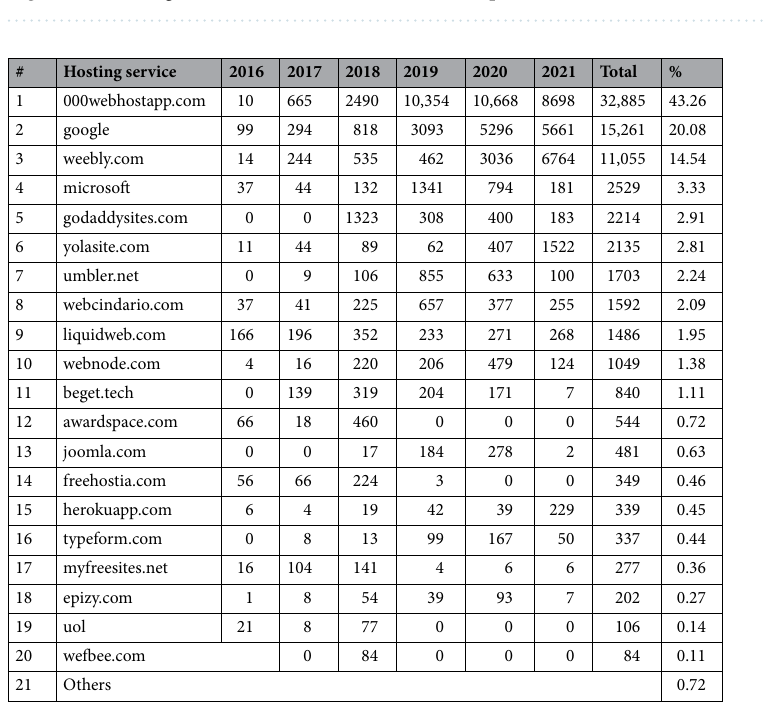
Figure 9. Hosting services involved in the evaluation process.